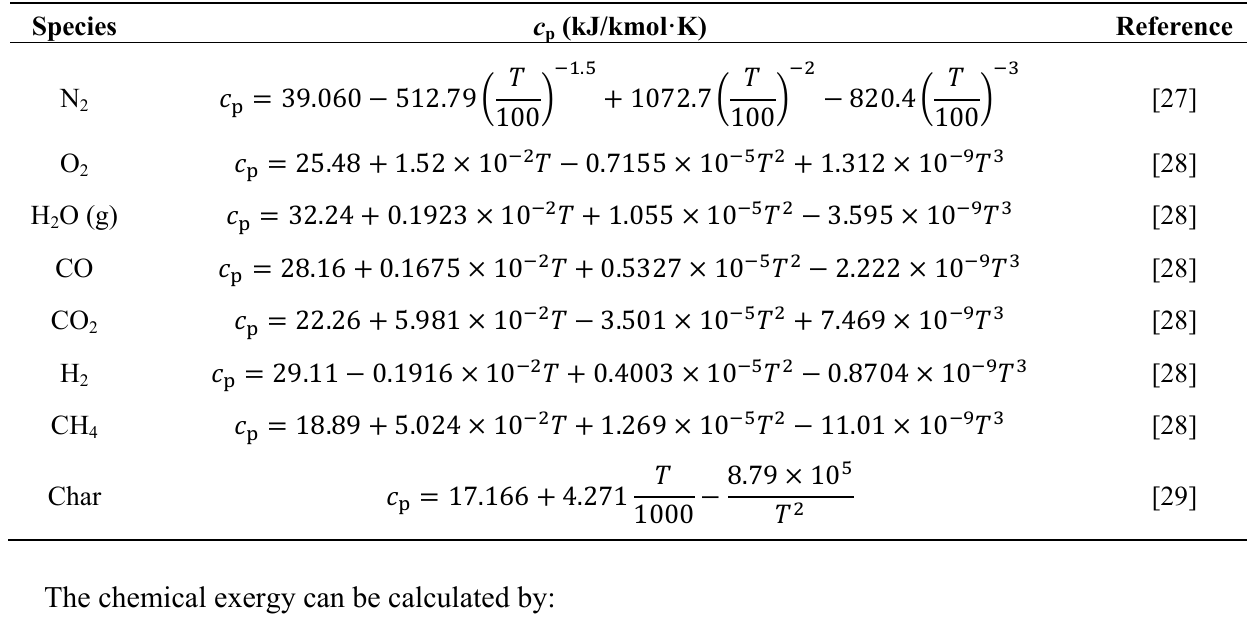
Table 2. Constant pressure specific heat capacity of some species.